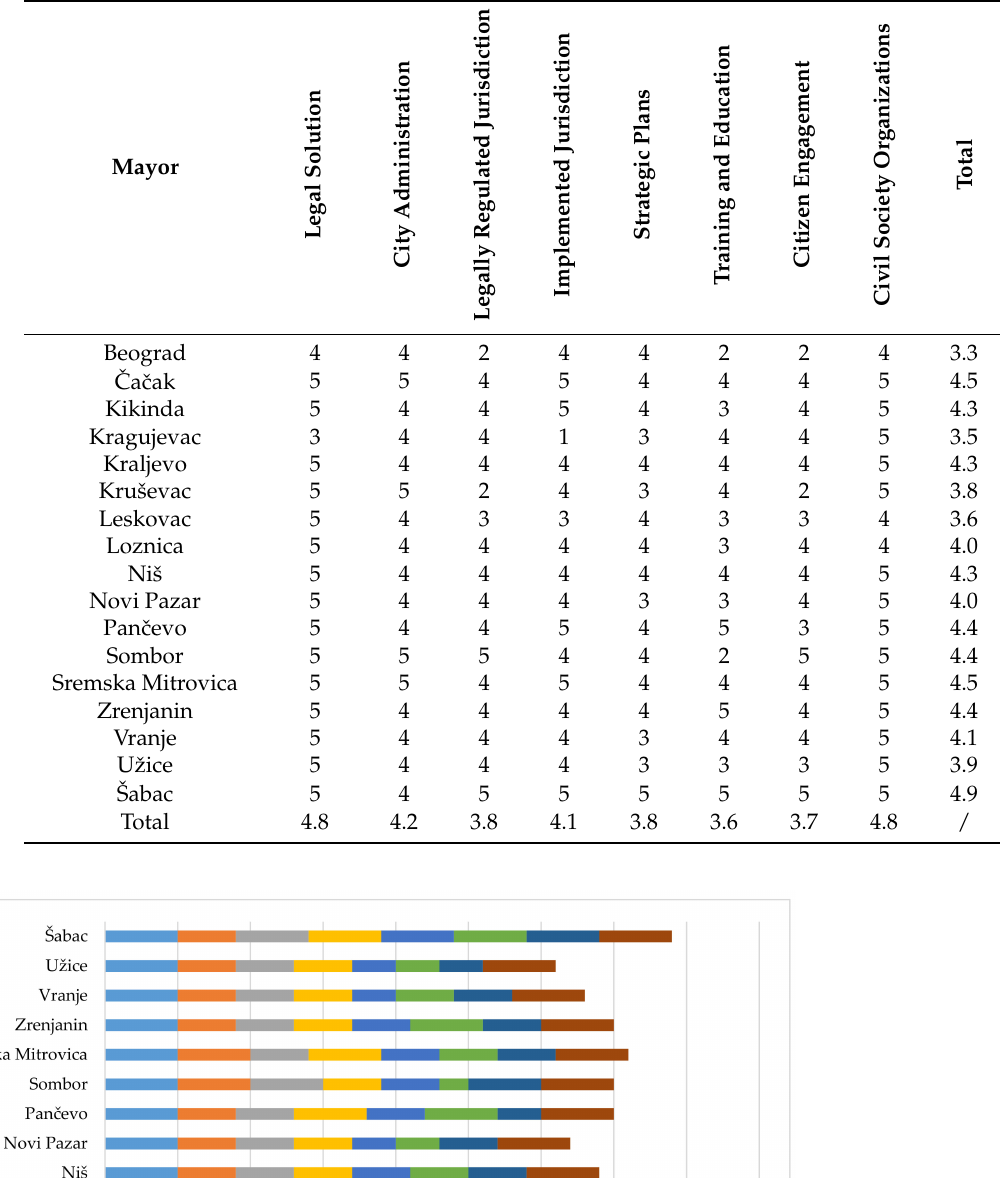
Table 7. Attitudes of heads (mayor) of disaster sectors in local self-government units.